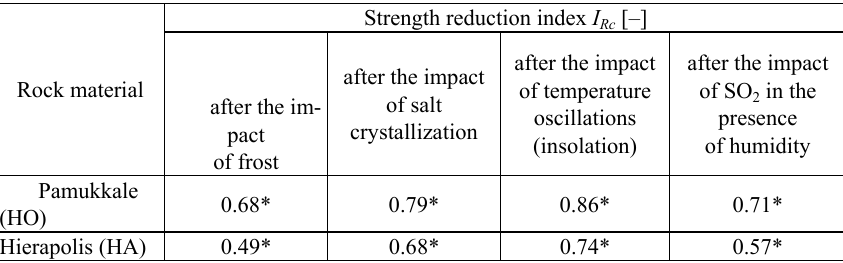
Table 1. Values of the strength reduction index I Rc in the analysed travertines